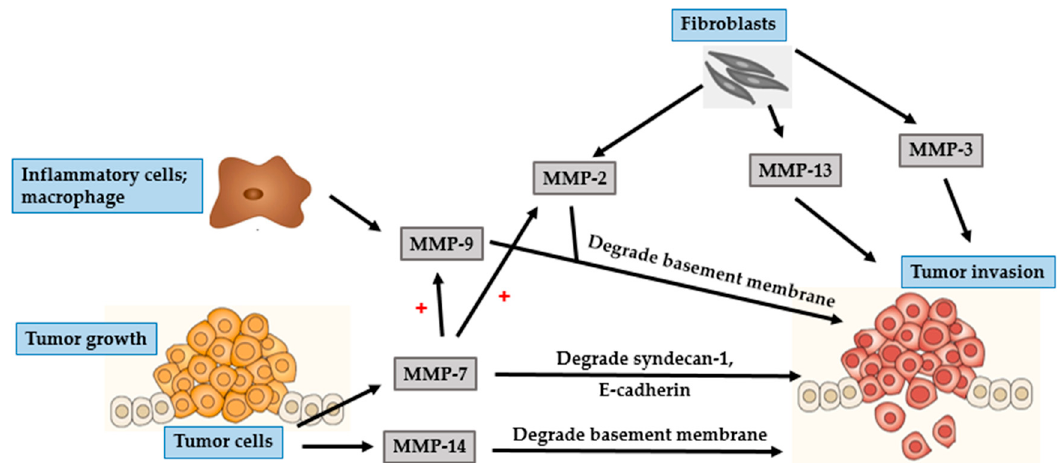
Figure 5. Role of MMPs in SCC tumor invasion. Fibroblasts secrete MMP-2, MMP-3, and MMP-13 to promote tumor invasion. Inflammatory cells secrete MMP-9 that degrades the basement membrane, leading to tumor invasion. SCC cells secrete MMP-7, which degrades syndecan-1, E-cadherin and induces the expression of MMP-2 and MMP-9. Additionally, SCC cells secrete MMP-14, which degrades the basement membrane. The expression of both MMP-7 and MMP-14 are important for tumor invasion.